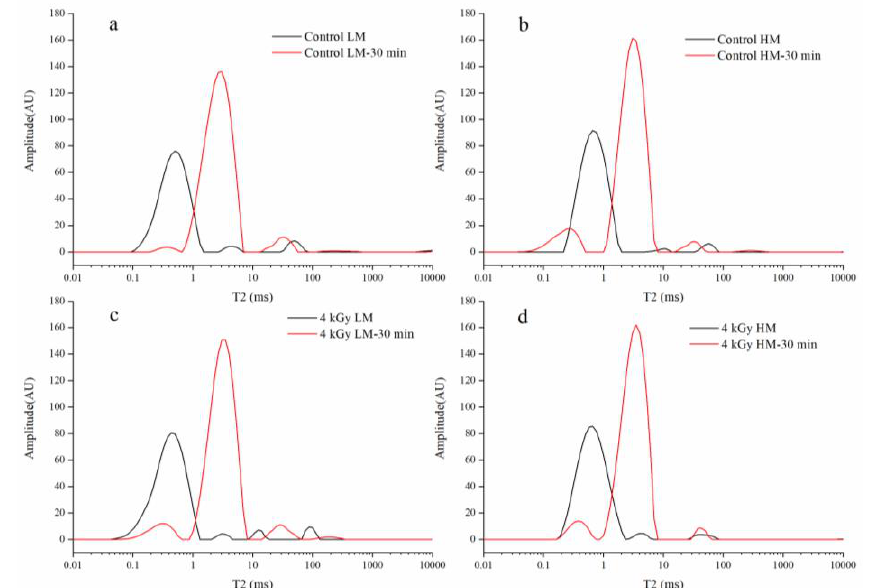
Figure 2. Water distribution in LM rice and HM rice samples after 30 min of soaking and treatment with di ff erent irradiation doses. ( a ) Control LM rice before and after 30 min soaking, ( b ) Control HM rice before and after 30 min soaking, ( c ) 4 kGy LM rice before and after 30 min soaking, ( d ) 4 kGy HM rice before and after 30 min